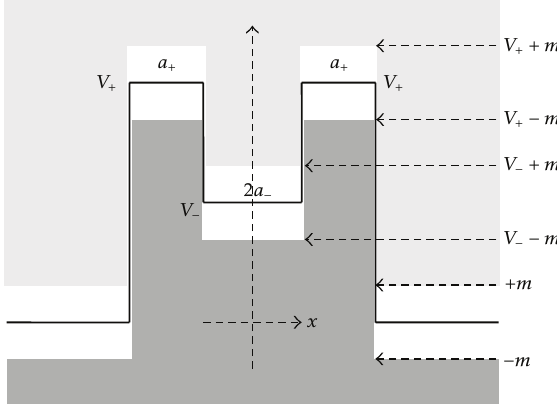
Figure 1: The potential configuration of the relativistic double barrier problem with V − > 2 m and V (cid:2) > V − (cid:2) 2 m . Oscillatory solutions are in the grey regions, whereas exponential solutions are in the white regions. The oscillatory positive/negative energy solutions are located in the light/dark grey